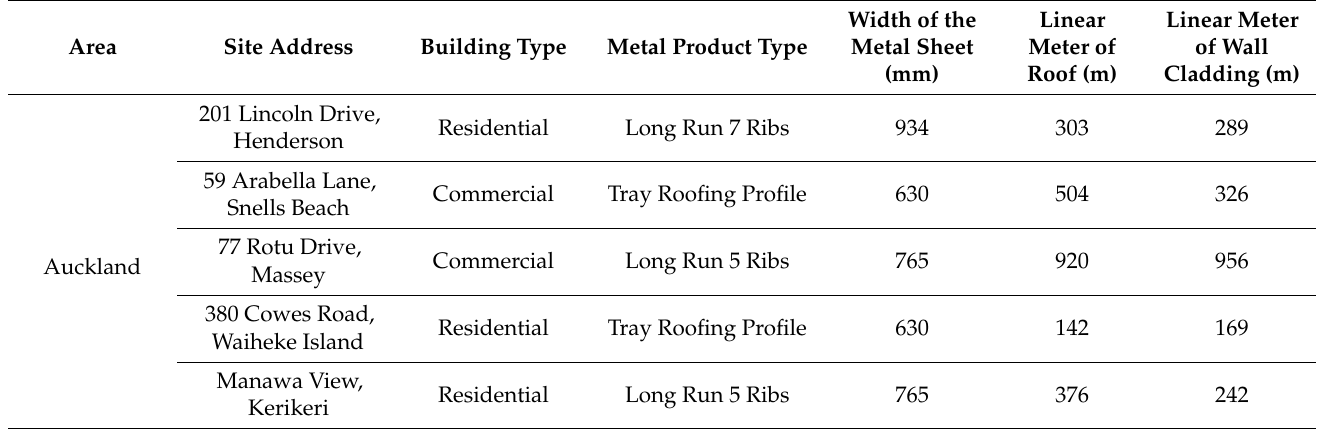
Table 2. Schedule of quantities of investigated specific metal